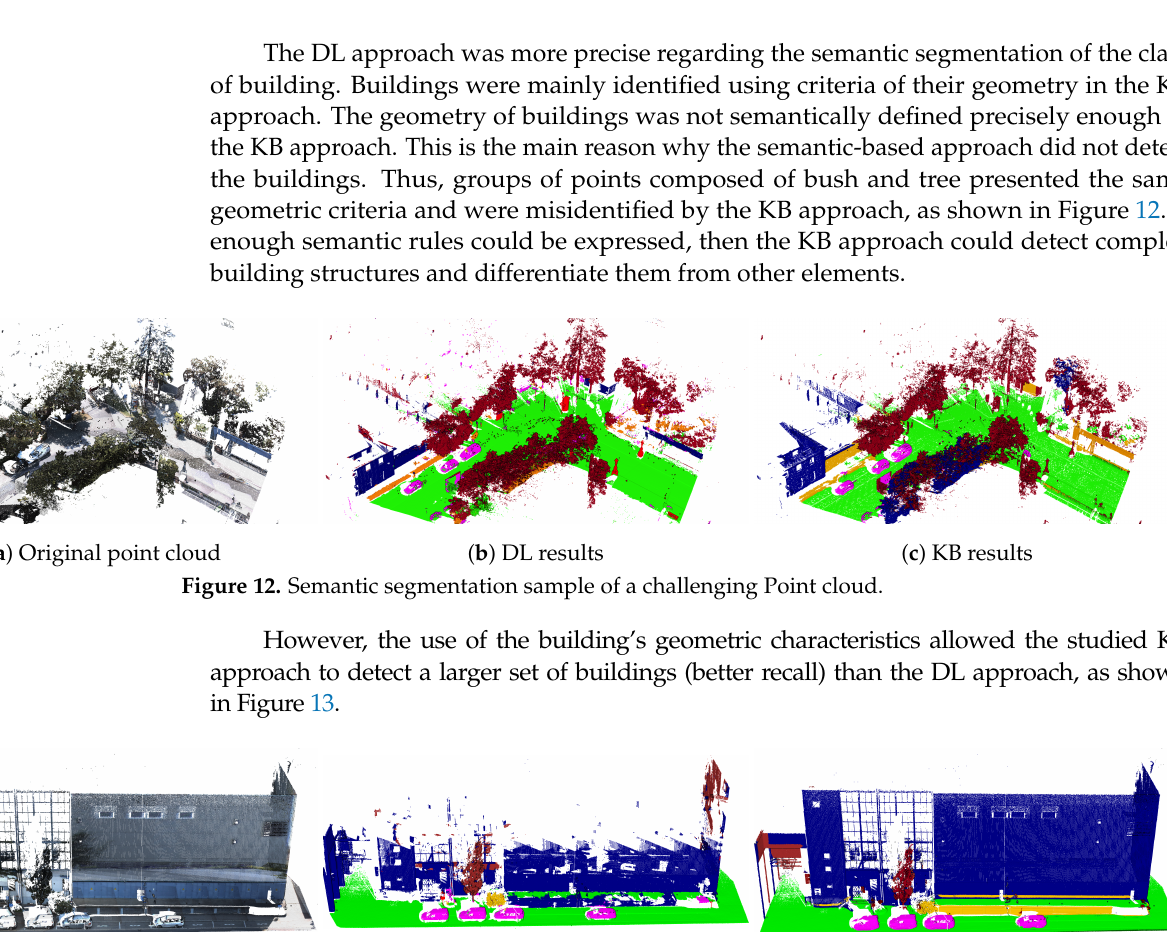
Figure 13. Semantic segmentation sample of Point cloud representing the façade of a